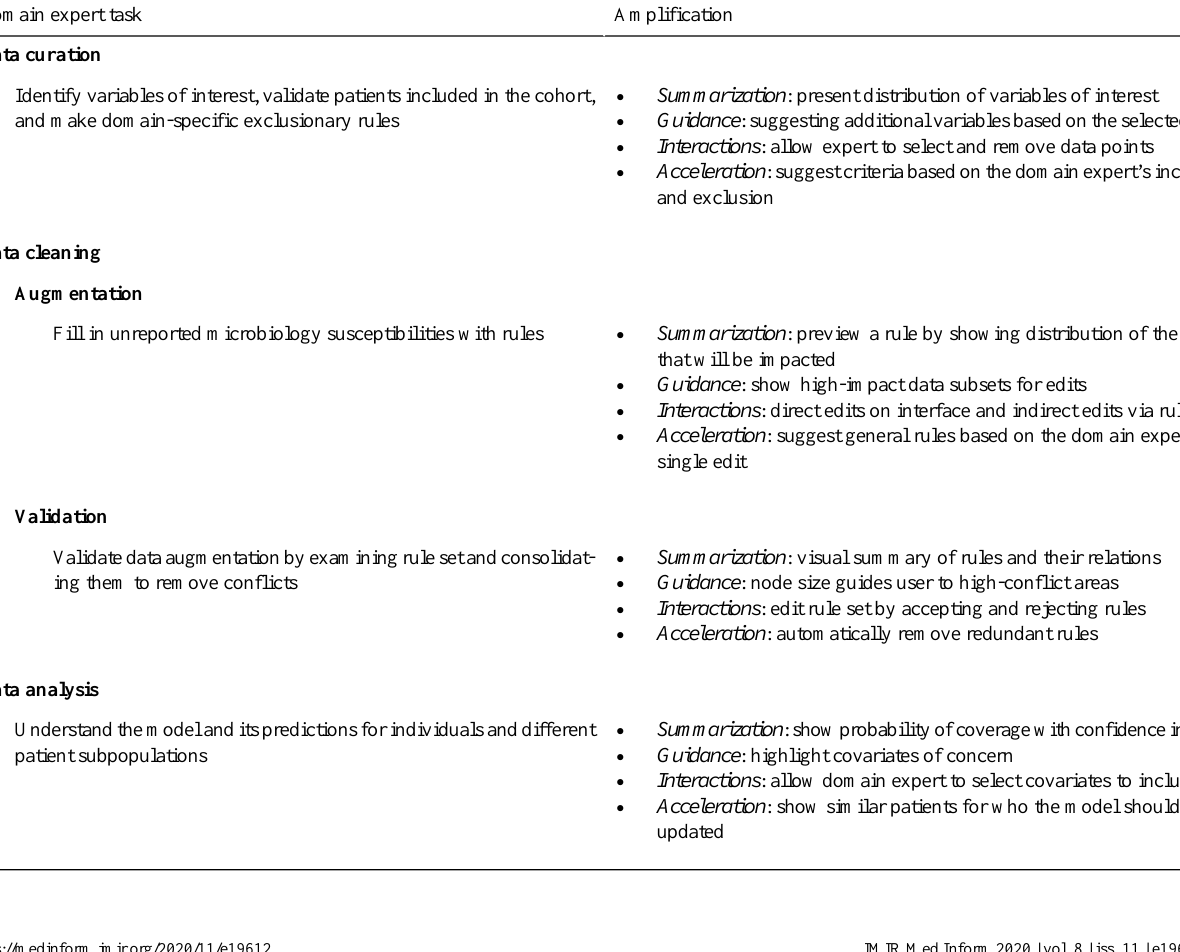
Table 2. Applying 4 dimensions of amplification to the clinical data pipeline for empiric antibiotic